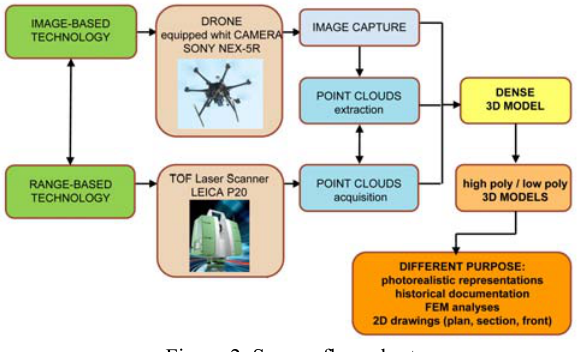
Figure 2. Survey